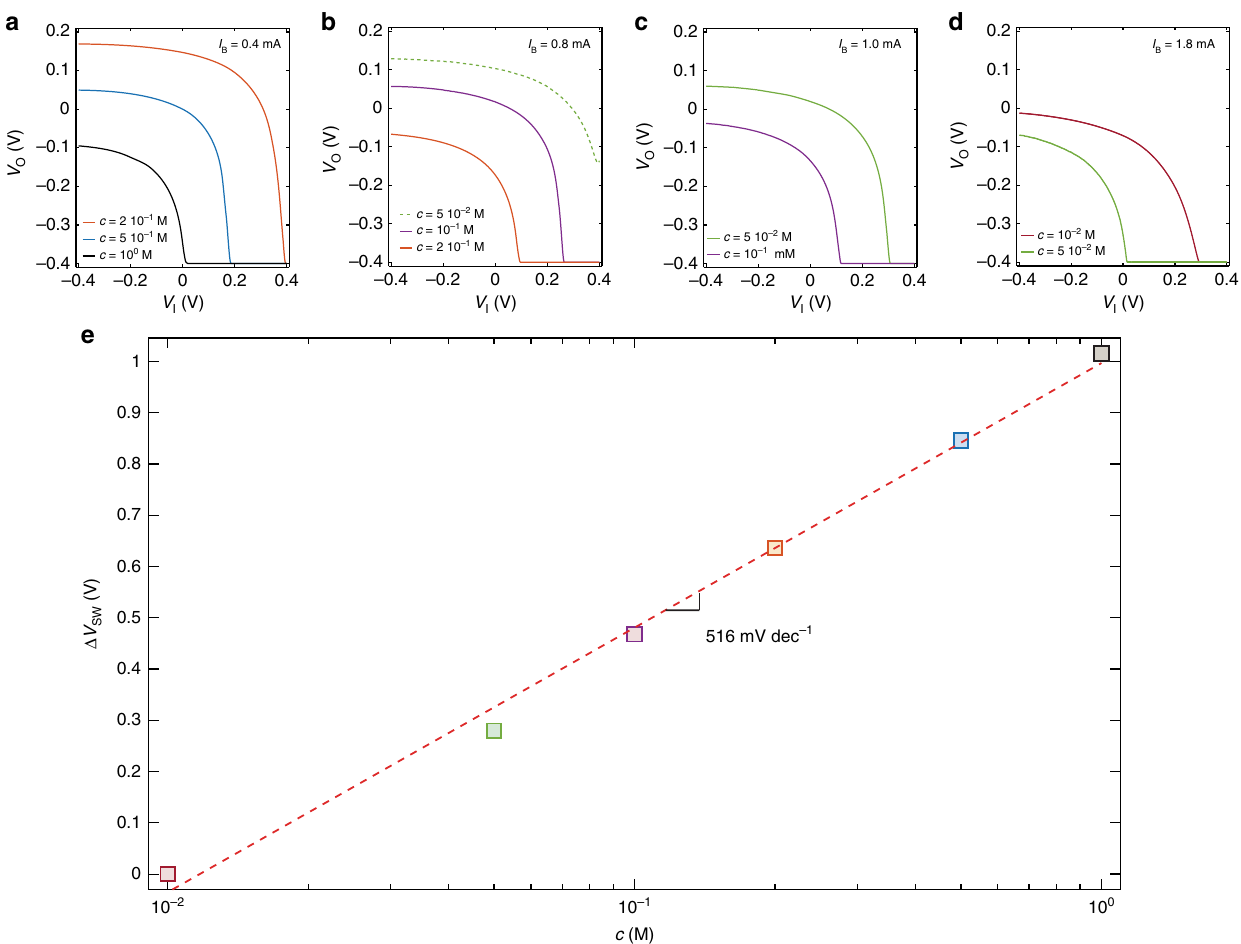
Fig. 3 Current-driven OECT used as ion sensor. a – d Measured transfer characteristics of a current-driven OECT at several NaCl concentration c , V DD = 0.4 V. a I B = 0.4 mA, b I B = 0.8 mA, c I B = 1.0 mA, d I B = 1.8 mA. e Cumulative switching voltage variation Δ V SWi + 1 = Δ V SWi + ( V SWi + 1 − V SWi ) as a function of ion concentration. The average sensitivity calculated by last-square linear approximation is of 516 mV dec − 1 . The gate is a tungsten foil and the OECTs geometries are: W = 1000 µ m, L = 300 µ m, t = 25